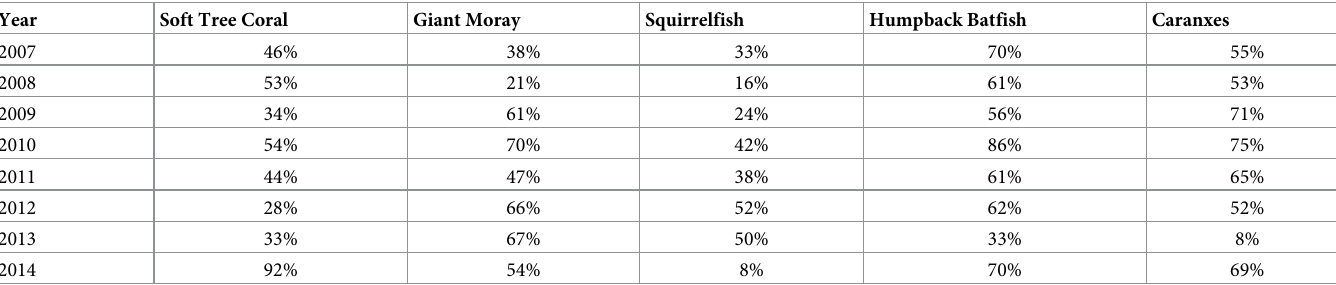
Table 4. Yearly sighting frequencies of BVSTEP best species subset from centroid aggregated taxa p/a data. Year Soft Tree